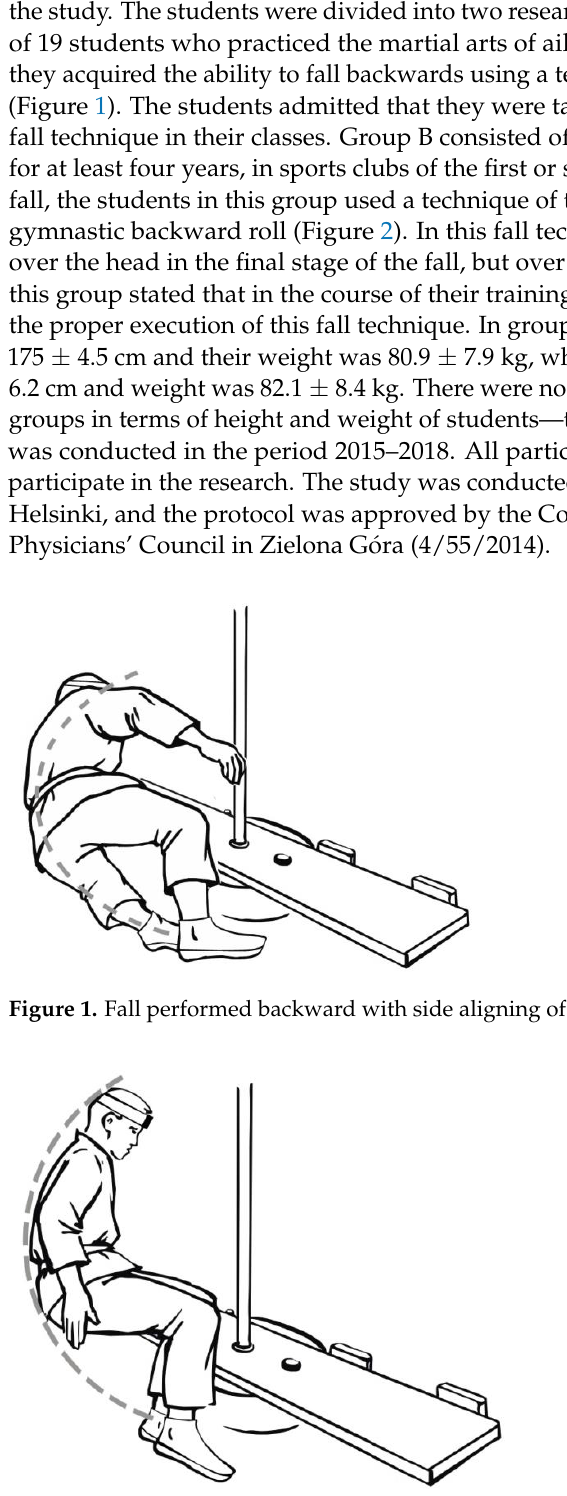
Figure 2. Fall performed in a way similar to a gymnastic backward roll.